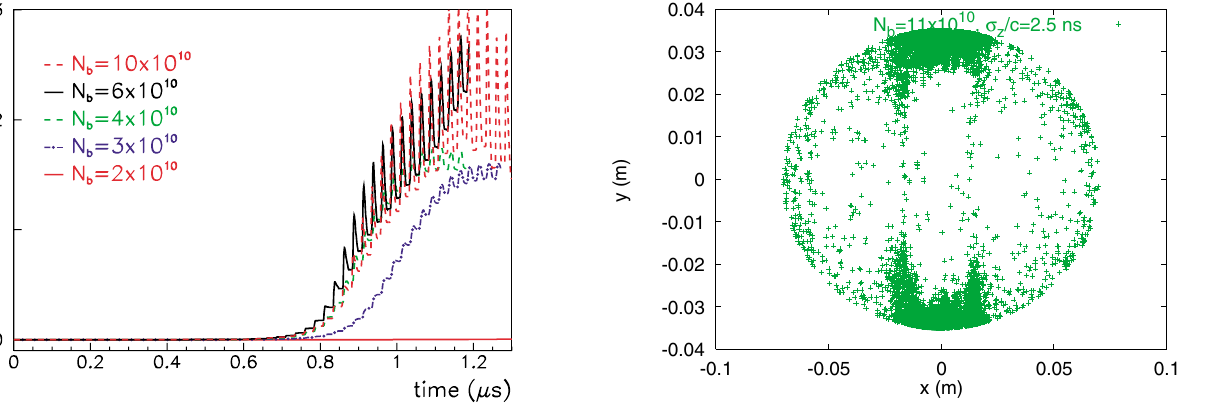
(cid:1) 2 (cid:2) 10 10 p = b and (cid:17) =c (cid:1) b z